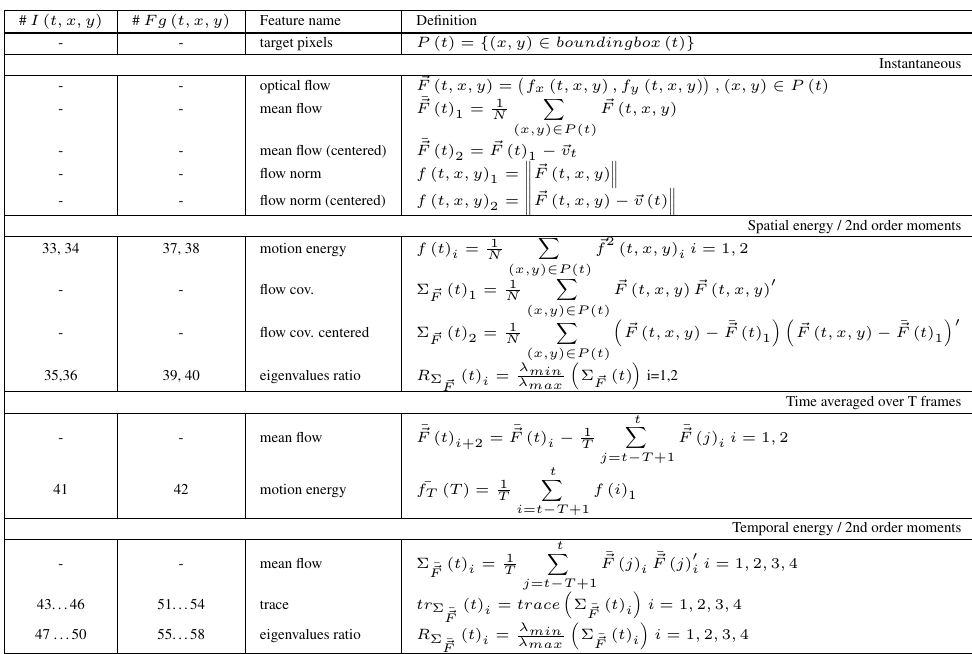
Table 2. Third and fourth group: Optical flow